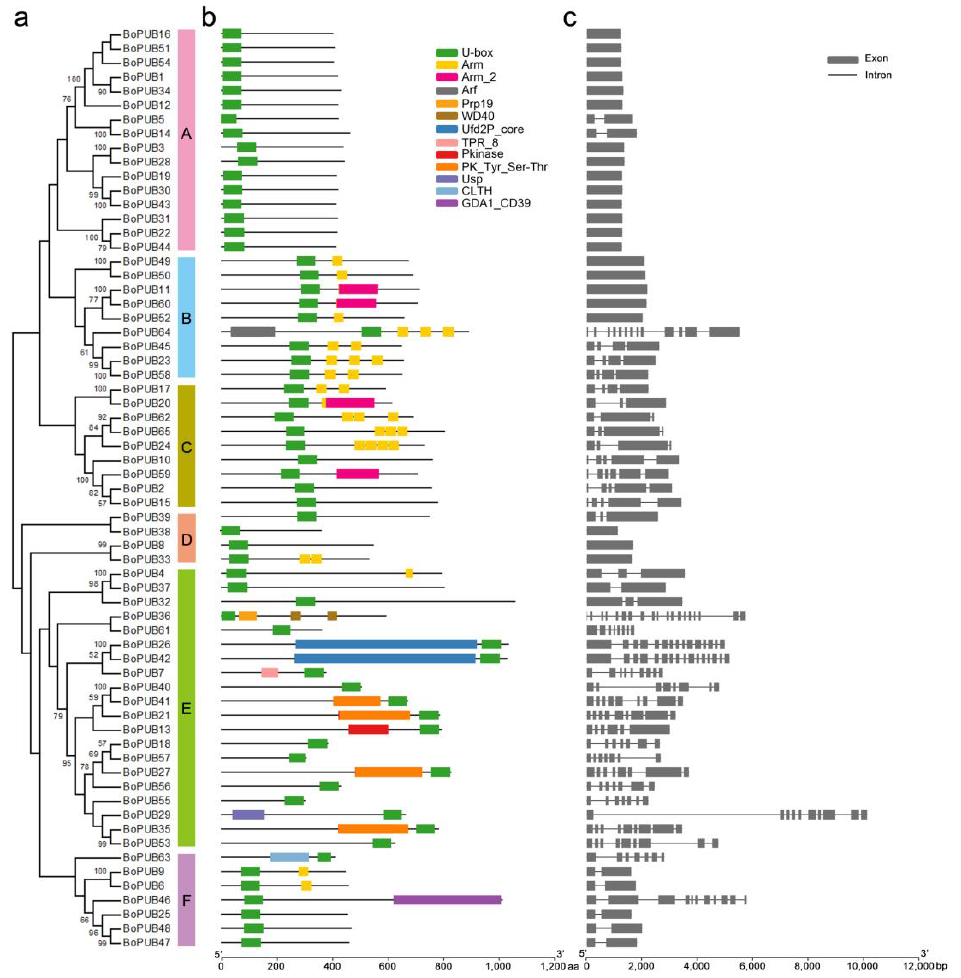
Figure 2. Phylogenetic relationships, conserved domain composition, and exon-intron structures of BoPUB genes. ( a ) Phylogenetic relationships of BoPUB genes. A phylogenetic tree based on the sequence alignment of BoPUB proteins was constructed by the MEGA 11.0 software, as described in Figure 1. Groups A–F are highlighted in six different colors corresponding to Figure 1, respectively. ( b ) Distribution of conserved domains in the BoPUB protein sequences. Sixty-five BoPUB protein sequences were submitted to the Pfam database to analyze the conserved domains of BoPUB proteins. The composition of conserved domains in the BoPUB protein sequences was visualized by the TBtools v1.095 software. Thirteen conserved domains marked in different colors are shown. Pfam accession number: U-box domain (PF04564.15), armadillo (Arm) repeat (PF00514.23), Arm_2 repeat (PF04826.13), ADP ribosylation factor (Arf) domain (PF00025.23), Prp19 domain (PF08606.13), WD40 repeat (PF00400.32), ubiquitin elongating factor core (Ufd2P_core) domain (PF10408.9), tetratri- copeptide repeat (TPR)_8 domain (PF13181.8), protein kinase (Pkinase) domain (PF00069.25), protein (Usp) domain (PF00582.28), CTLH/CRA C-terminal to LisH motif (CTLH) domain (PF10607.11), and GDA1/CD39 nucleoside phosphatase (GDA1_CD39) domain (PF01150.19). ( c ) Exon-intron structures of BoPUB genes. The genomic and coding sequences of BoPUB genes were submitted to the Gene Structure Display Server to analyze the exon-intron structures of BoPUB genes. Grey bars indicate exons, and black lines indicate